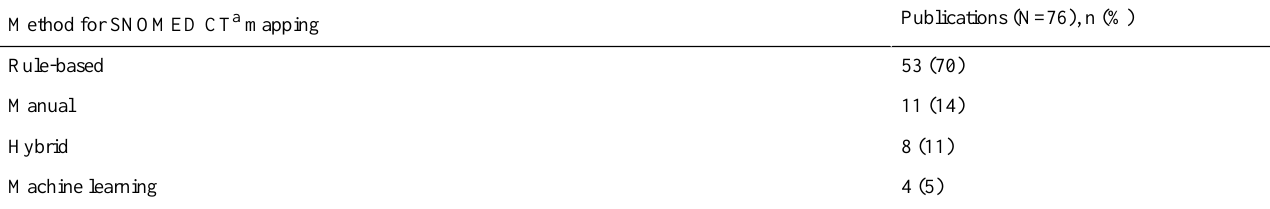
Table 6. Method used for mapping free-text data to Systematized Nomenclature of Medicine Clinical